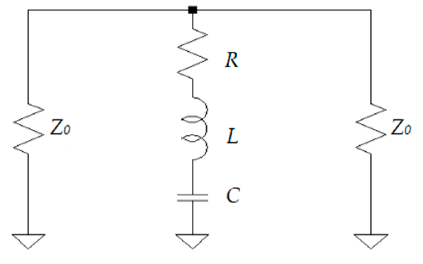
Figure 3. Circuit model for a simple series resonator.